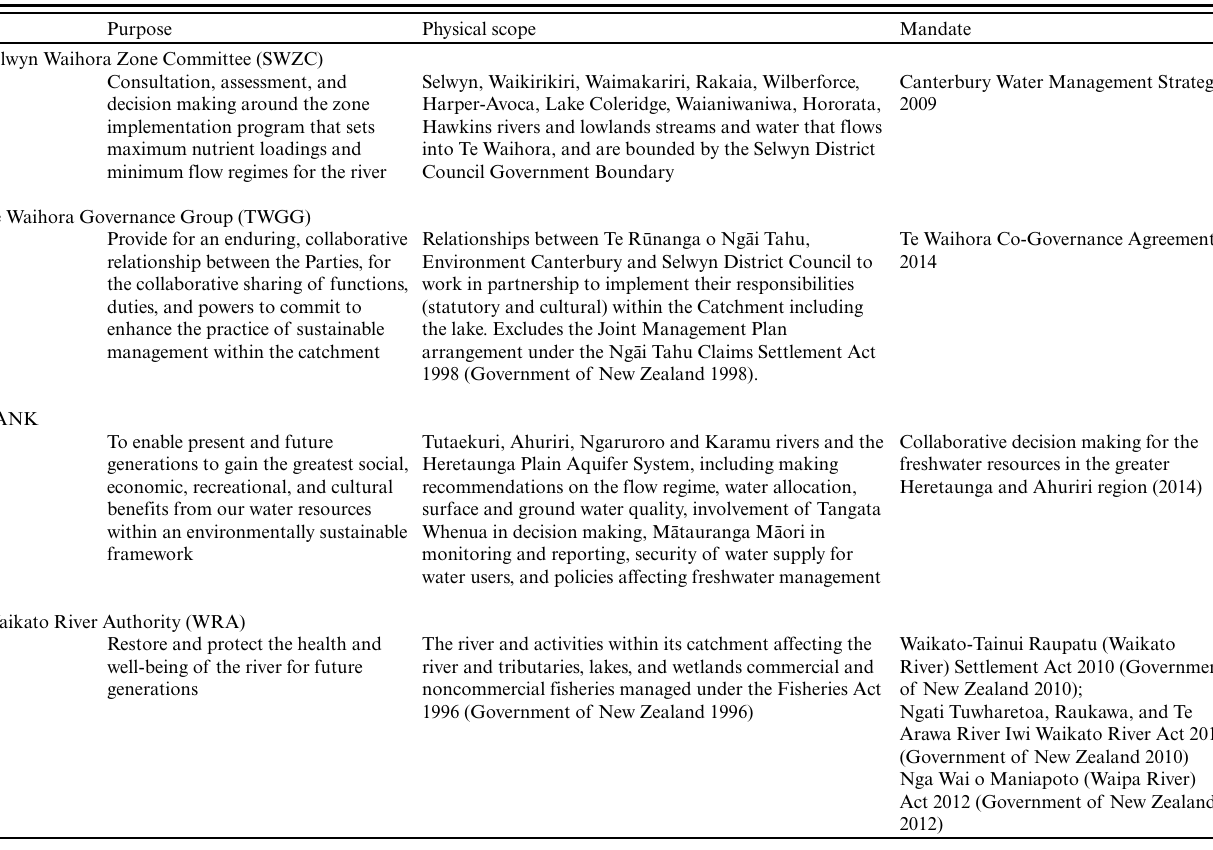
Table 2 . Descriptive context of the New Zealand collaborative